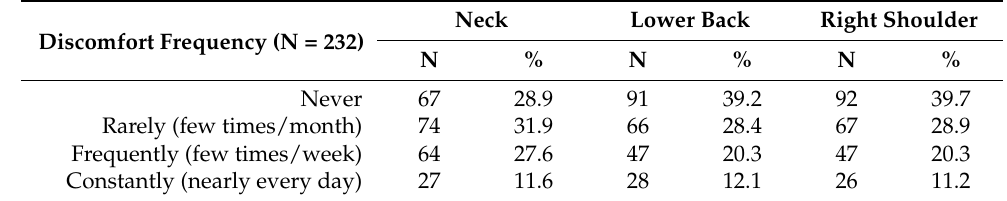
Table 2. Discomfort frequency of the three most reported MSD body regions (neck, lower back, and right